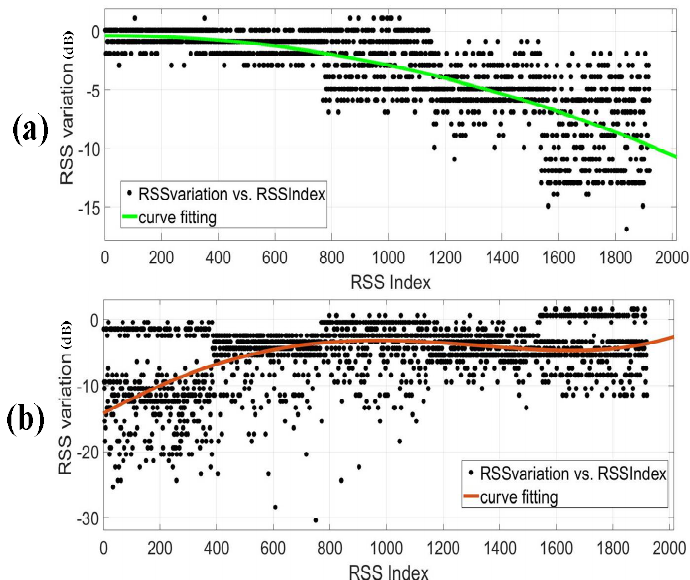
Figure 9. The RSS variation rules of different links. ( a ) The RSS variation of a link in the drawing room 1. ( b ) The RSS variation of a link in the drawing room 2. 1. ( b ) The RSS variation of a link in the drawing room